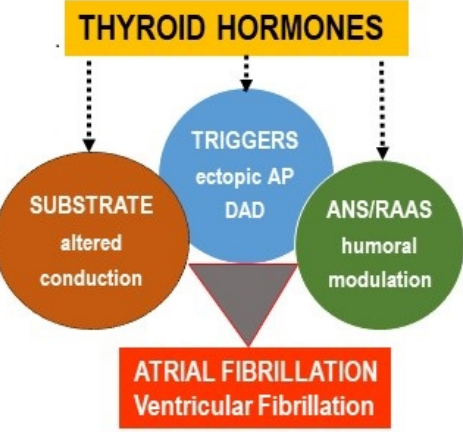
Figure 1. An excess of thyroid hormones (TH) promotes the occurrence of the main factors involved in cardiac arrhythmogenesis: Substrate, triggers, autonomous nervous system (ANS), and renin–angiotensin–aldosterone system (RAAS) imbalance.